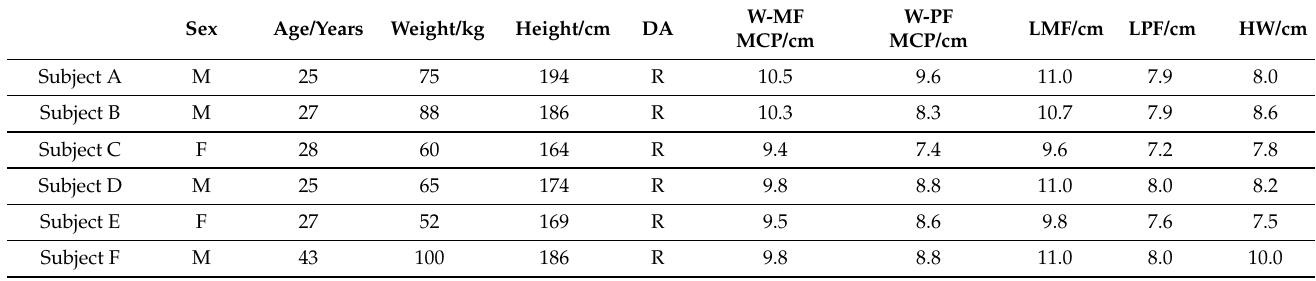
Table 1. Sex, age, dominant arm, and anthropometric properties of the